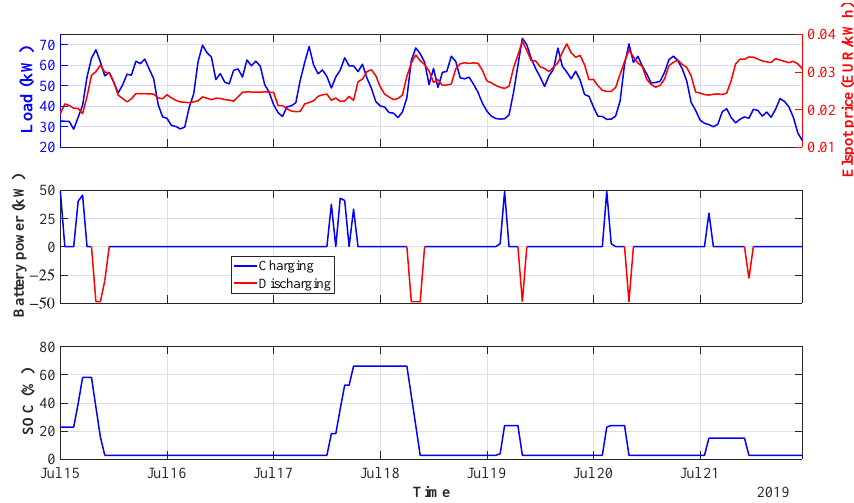
Figure 12. Cost-efficient operation of